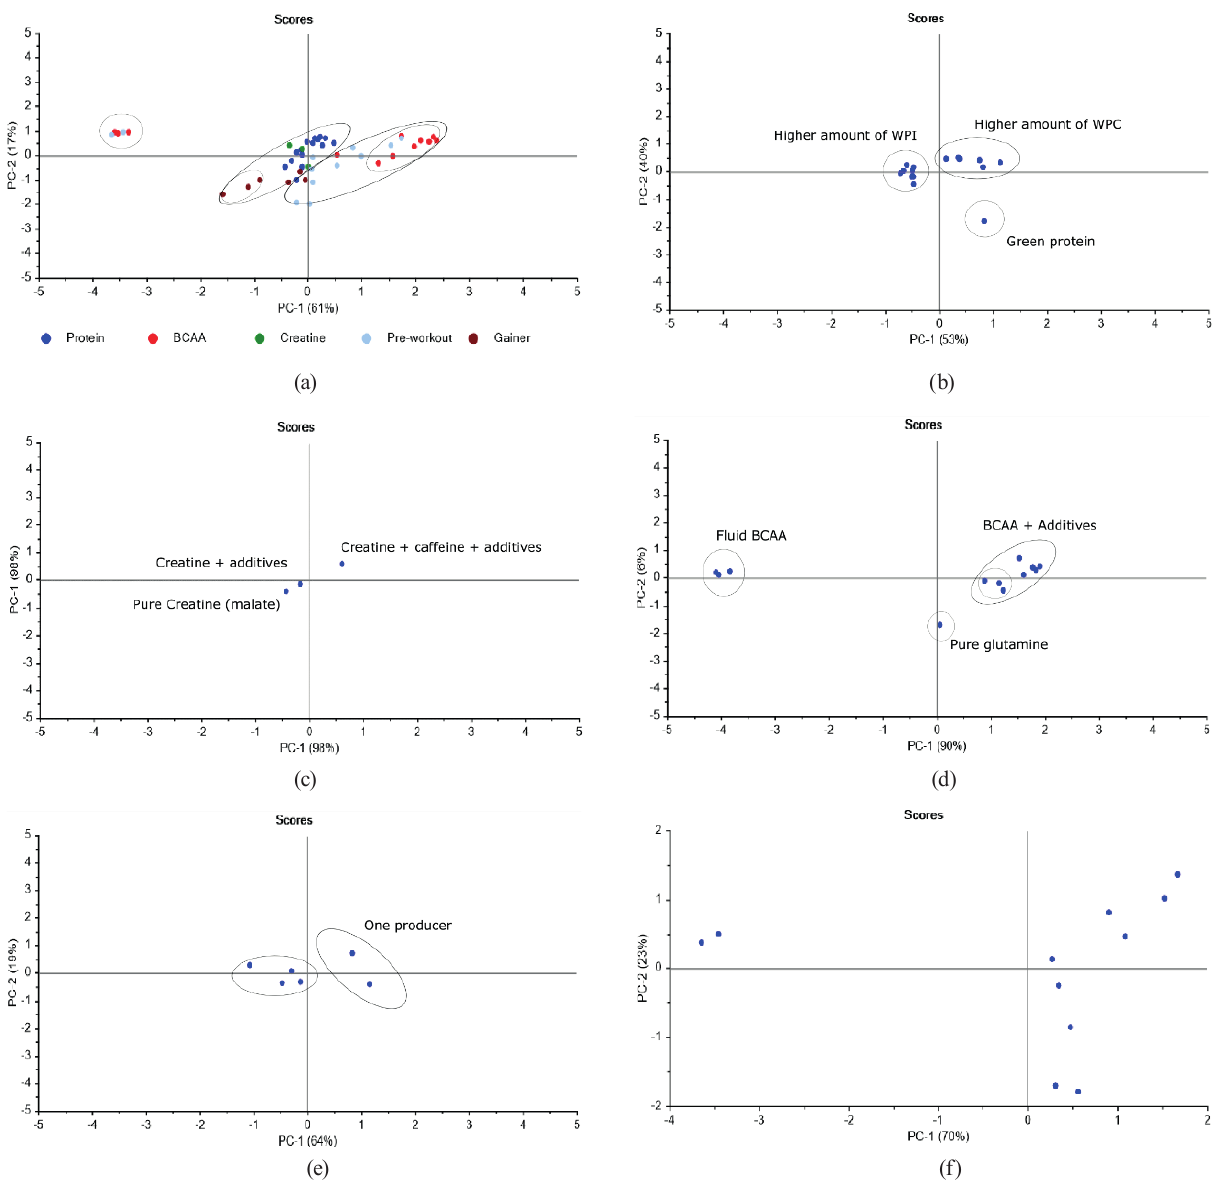
Figure 2 PCA results for medium infrared spectra of sports supplements. Scores plot for two significant principal components: PC1 vs PC2. (a) all samples and full spectra at 4000–600 cm –1 ; (b) proteins; (c) creatines; (d) BCAA; (e) gainers; (f) pre-workouts